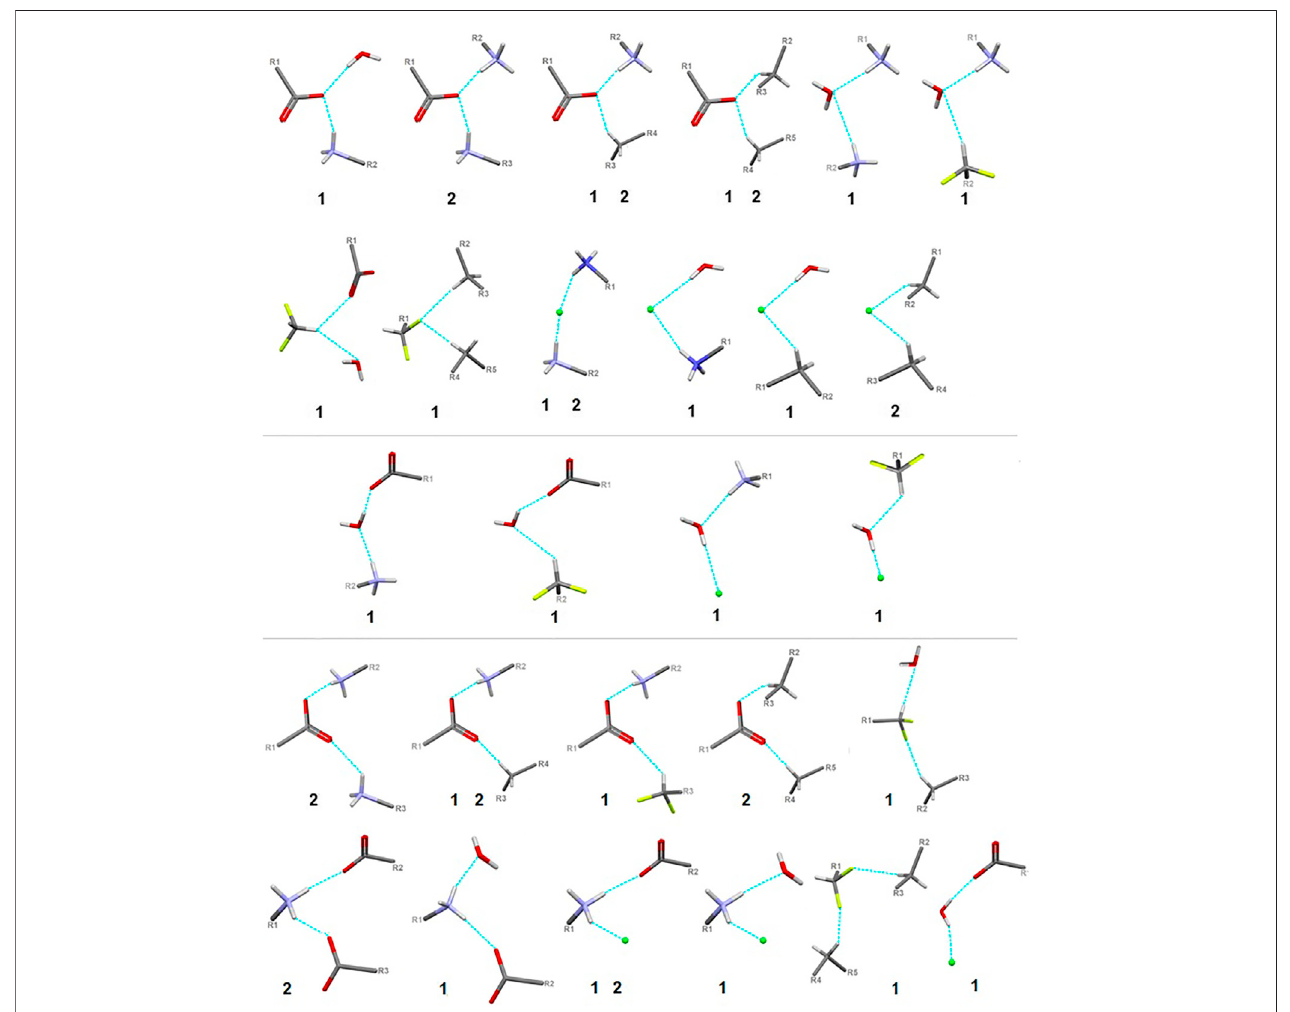
FIGURE 9 | Schematic presentation of all types of interactions in the analyzed structures: above – bifurcated H-bonds (including bifurcated donor and bifurcated acceptors); in the middle – ambivalent; bottom – others (red - oxygen, grey - carbon, blue - nitrogen, greeen - Cl - , lime - fl uorine).